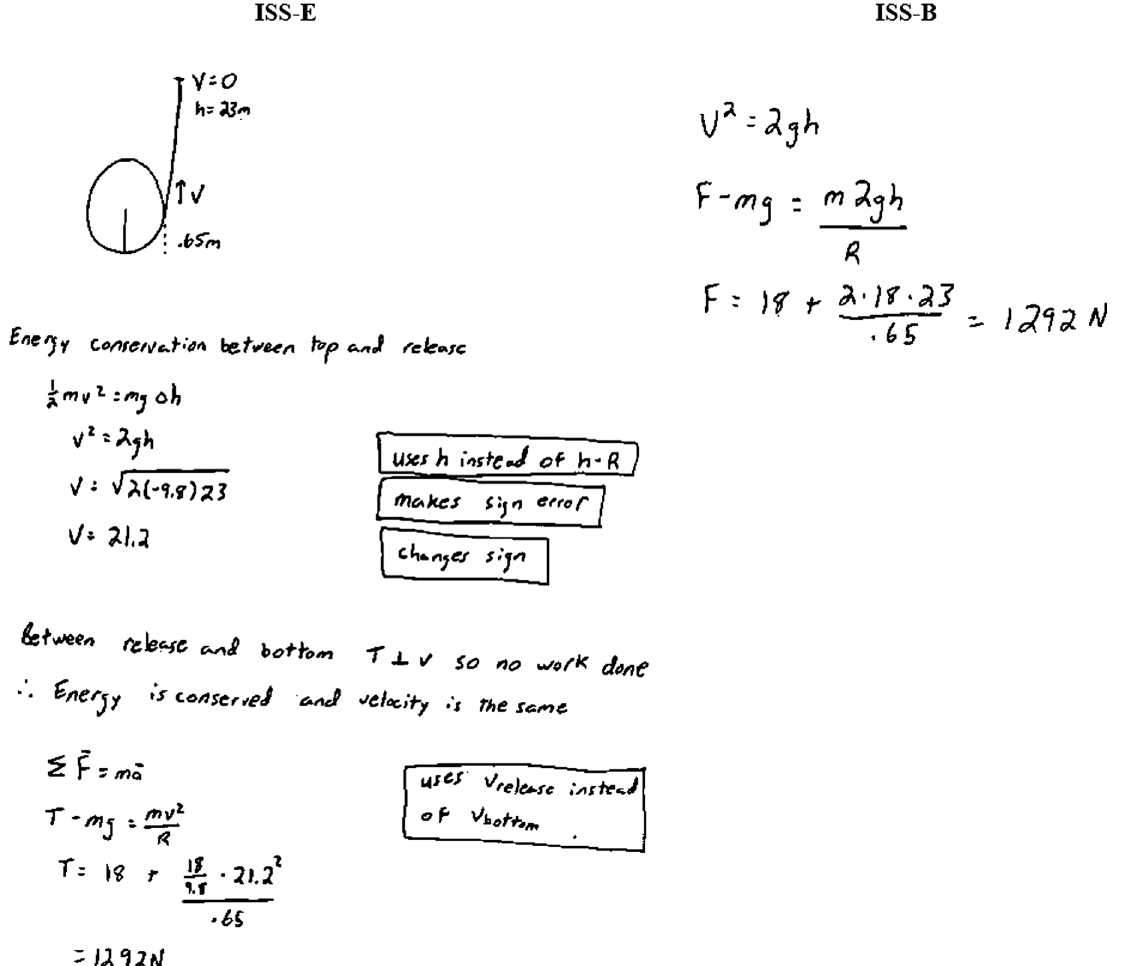
FIG. 2. For the introductory physics problem, an introductory student solution that is elaborated (ISS-E) and an introductory student solution that is brief (ISS-B).